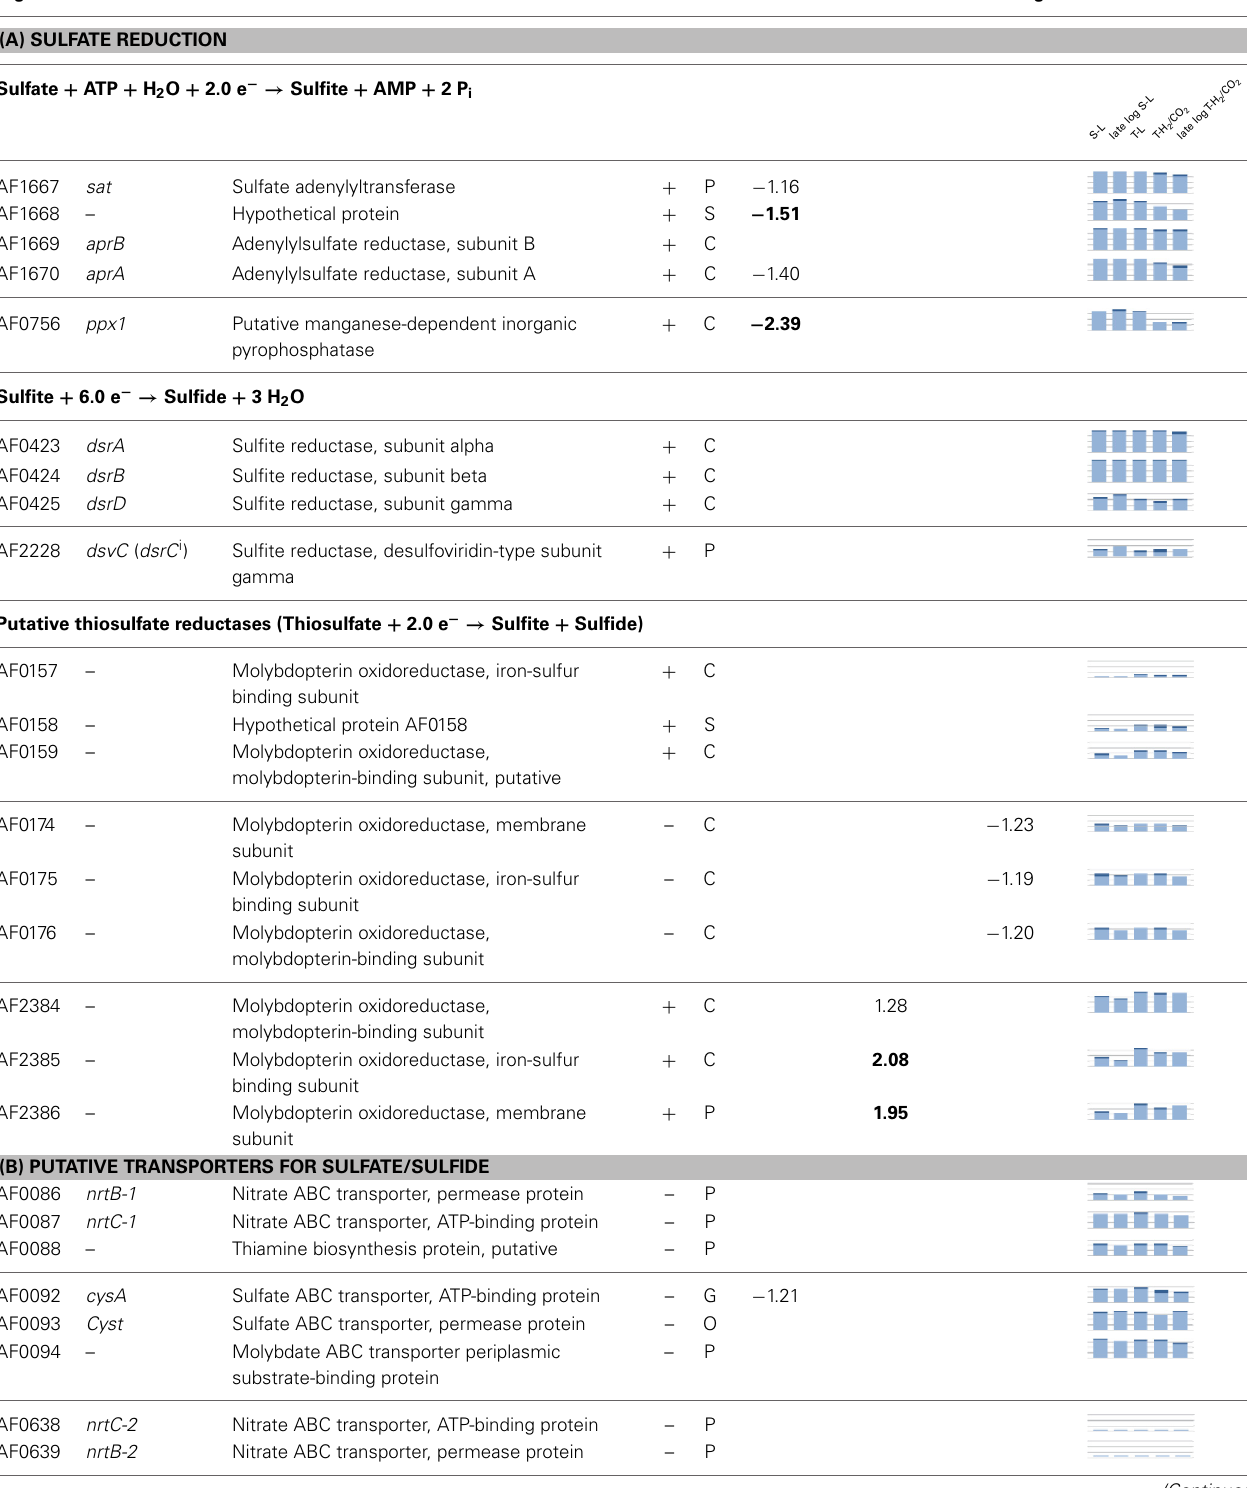
Table 1 | Differential expression (fold change; above 1.5 in bold, ANOVA; p -value 0.00001) of selected genes corresponding to processes in Figure 5, graphs display transcriptional abundance (1–3 fold average expression) and standard deviance around mean (dark area). Locus